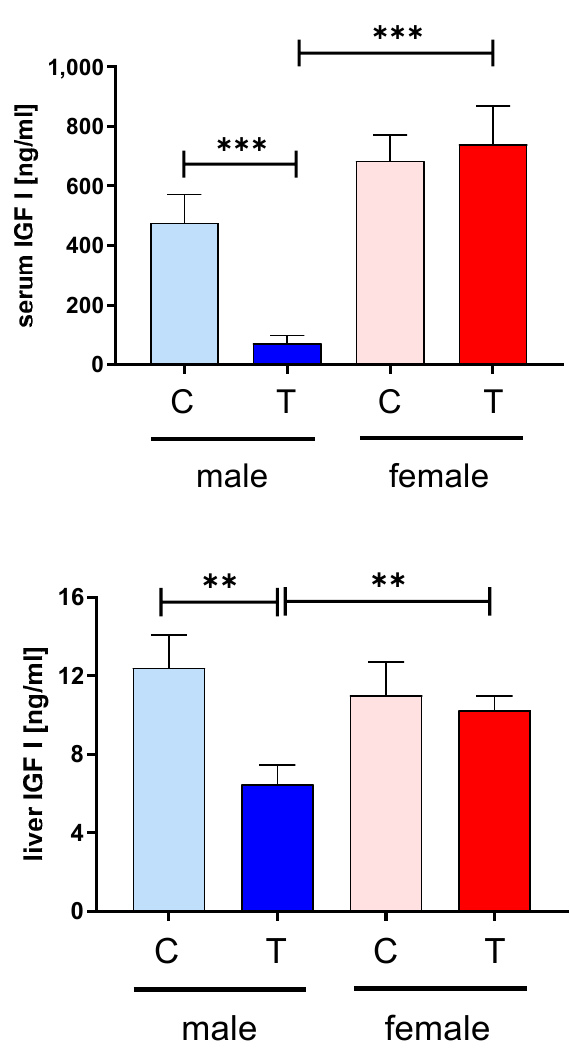
Figure 8. Concentrations of IGF-1 in serum (left panel) and the liver (right panel) from male (blue) and female (red) IGFBP-2 transgenic mice (T) and non-transgenic (C) littermates (DU6P / C57BL / 6). Analysis was performed by ELISA as described in Section 2 (mean ± SEM; age: 7 weeks; n > 9; **: p < 0.01; ***: p < 0.001).